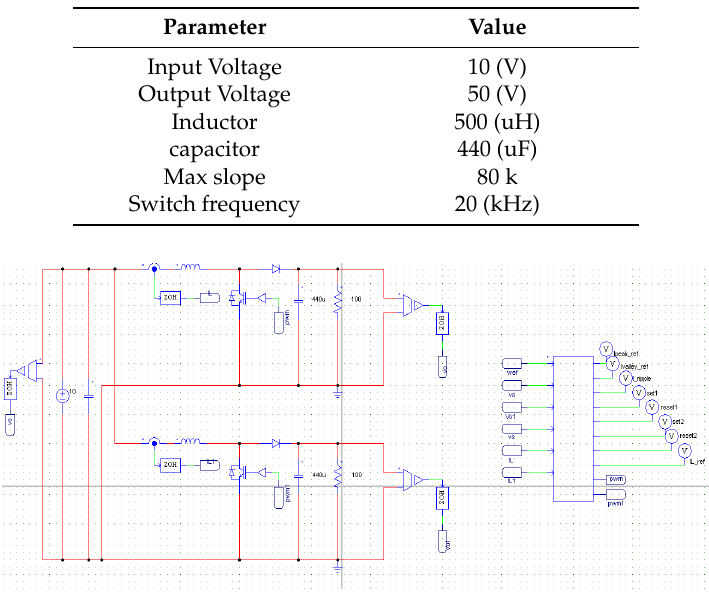
Figure 16. Boost converter circuit in Powersim (PSIM) simulation.